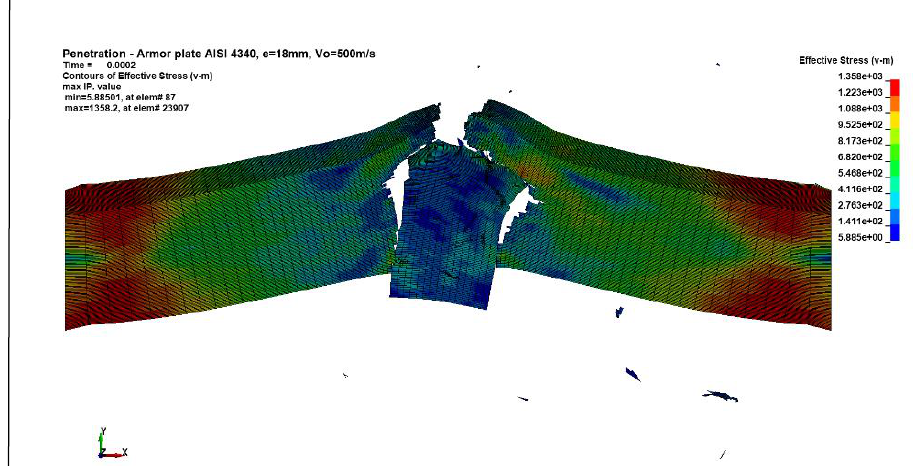
Figure 28 – Von Misses equivalent stress, time of analysis 0.2 ms – Model 4 Рис. 28– Von Misses эквивалентное напряжение, время анализа 0.2 ms – Модель 4 Слика 28 – Von Misses-ов еквивалентни напон, време анализе 0,2 ms – модел 4